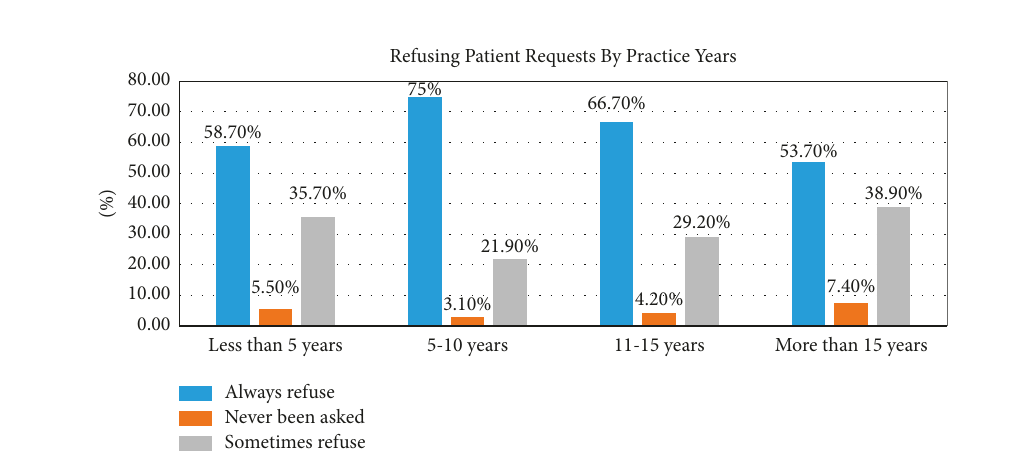
Figure 1: Percentage of responses denying patient requests for unnecessary antibiotics.